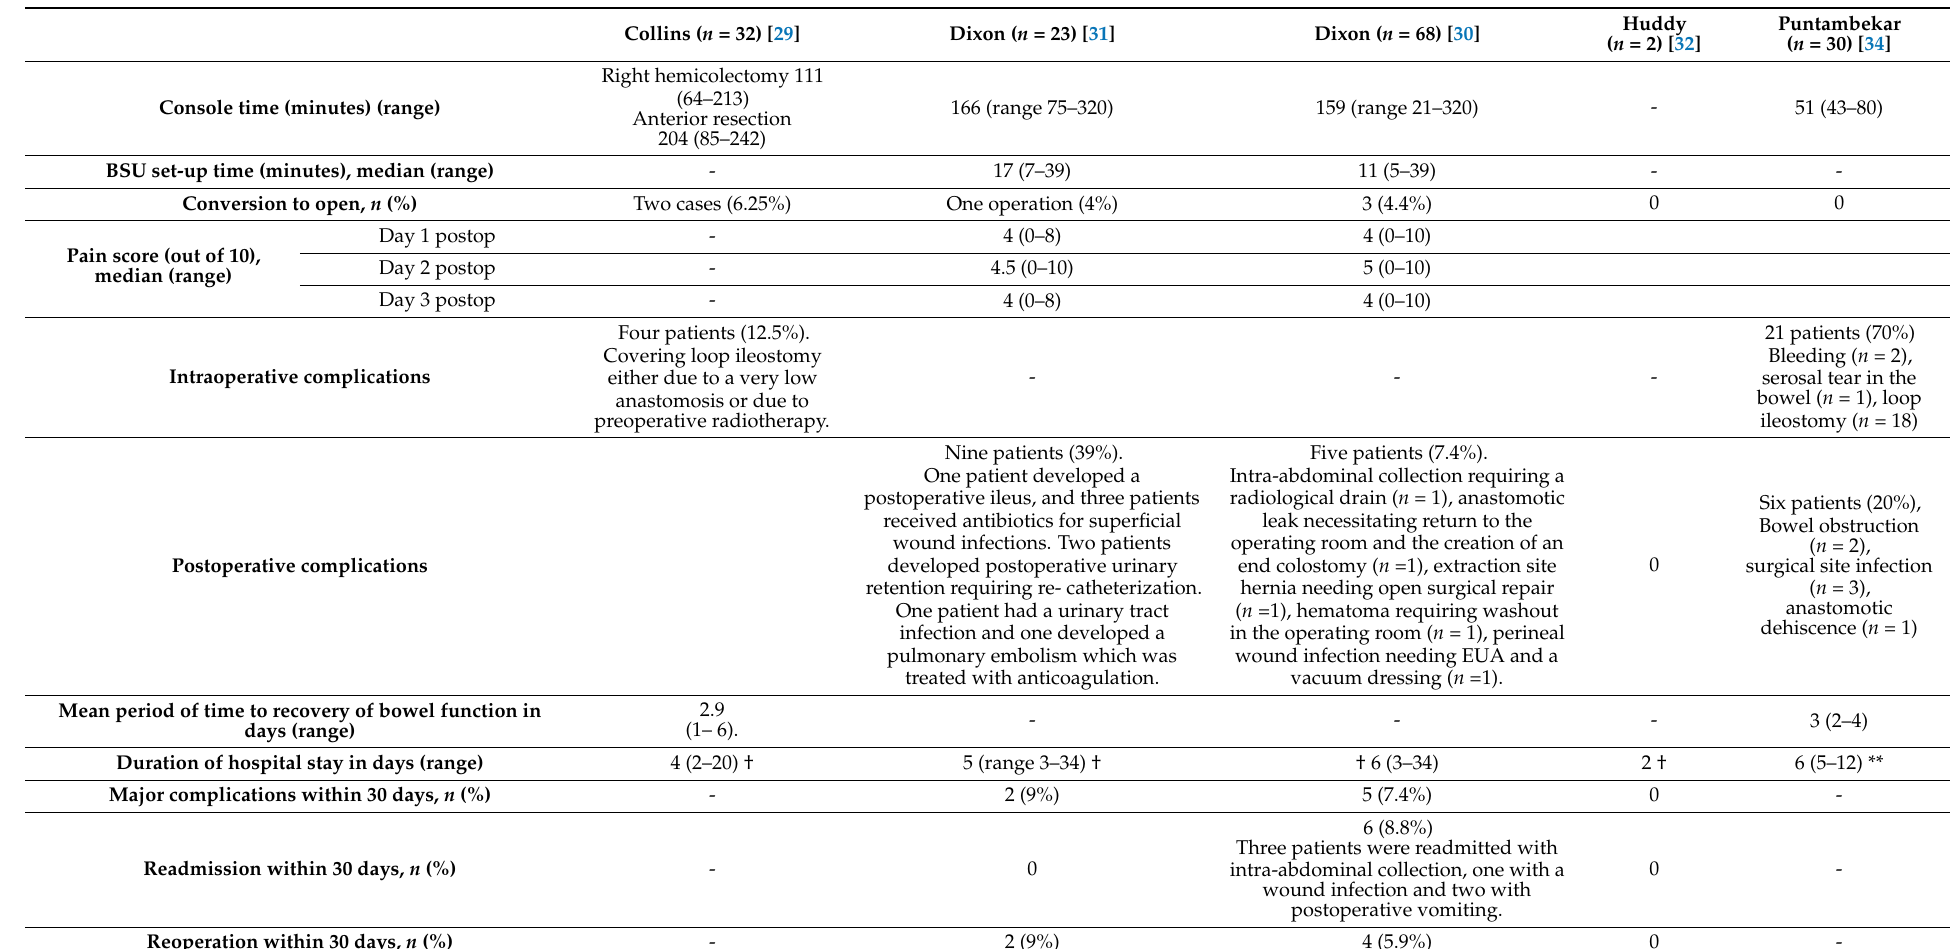
Table 6. Perioperative and postoperative outcomes of patients who underwent colorectal surgery using the Versius system